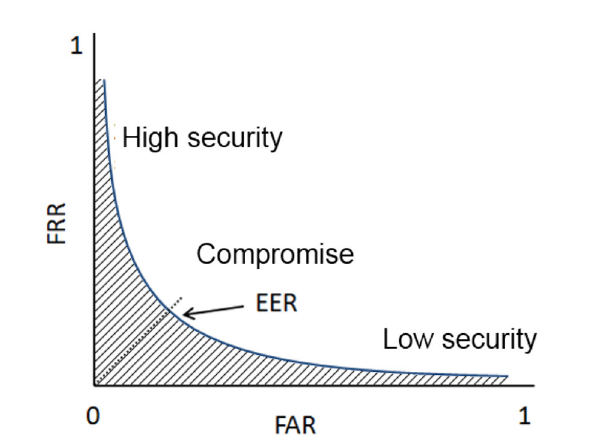
FIGURE4 Definition of the ROC curve: evolution of the False acceptance rate vs. the false rejection rate.